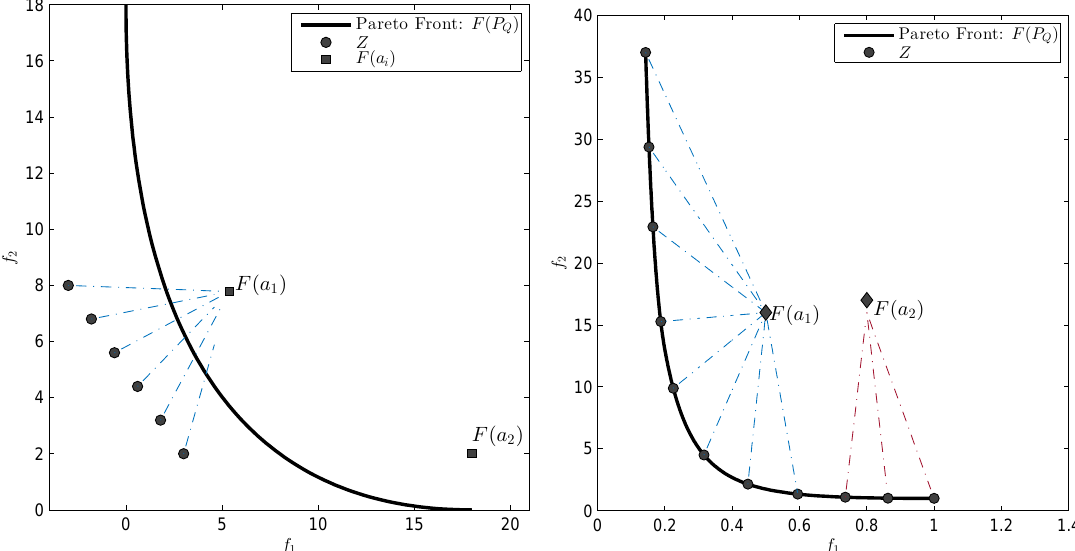
Figure 7. Dominance and distance are different concepts. ( Left ) an example where a 1 and a 2 are mutually non-dominated, but where | I 2 | = 0. ( Right ) an example where a 1 ≺ a 2 , but | I l |(cid:54) = 0 for l ∈ { 1,2 }